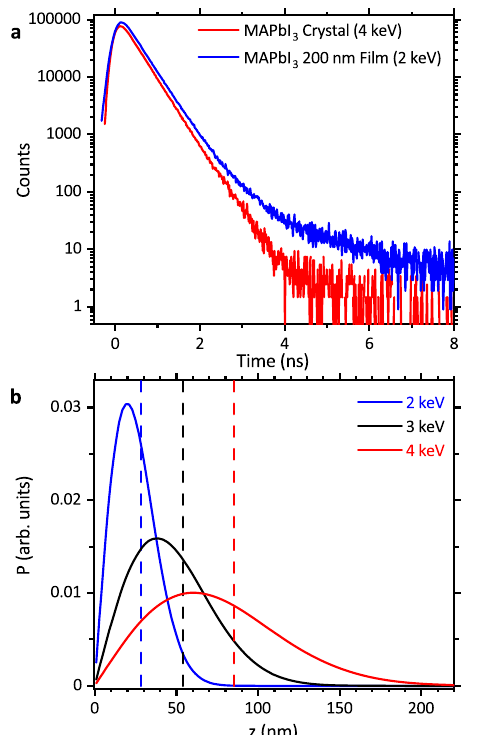
defect obtained using Pb